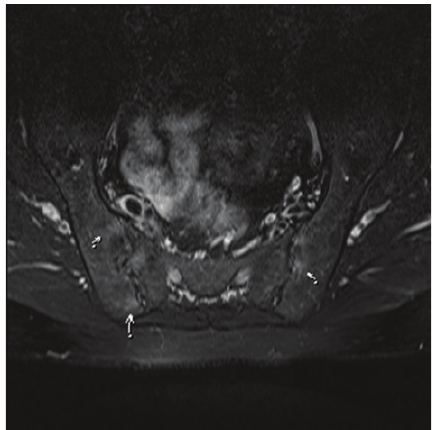
Figure 2: MRI of patient with KS showed active